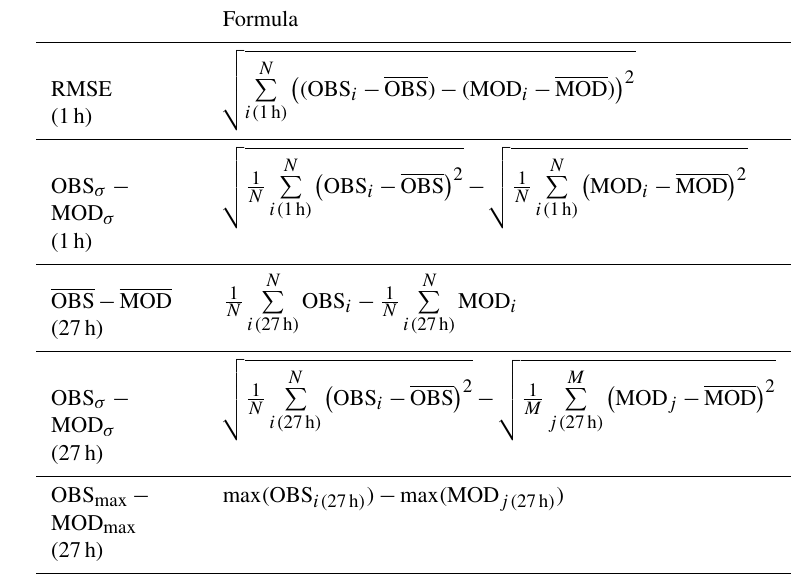
Table A1. Precipitation validation metrics used in Tables 2 and 3. N denotes the total number of measurements at the rain gauge stations, hourly (1h) or accumulated (27h). M denotes all model grid points over land. For the first two metrics, all hourly values between 26 October at 13:00UTC and 27 October at 15:00UTC are considered, and COSMO-CLM is interpolated to the station’s location. The third metric is an average of accumulated precipitation, with COSMO-CLM values interpolated to the station’s location. The last two metrics considered all observed and simulated precipitation values over land.